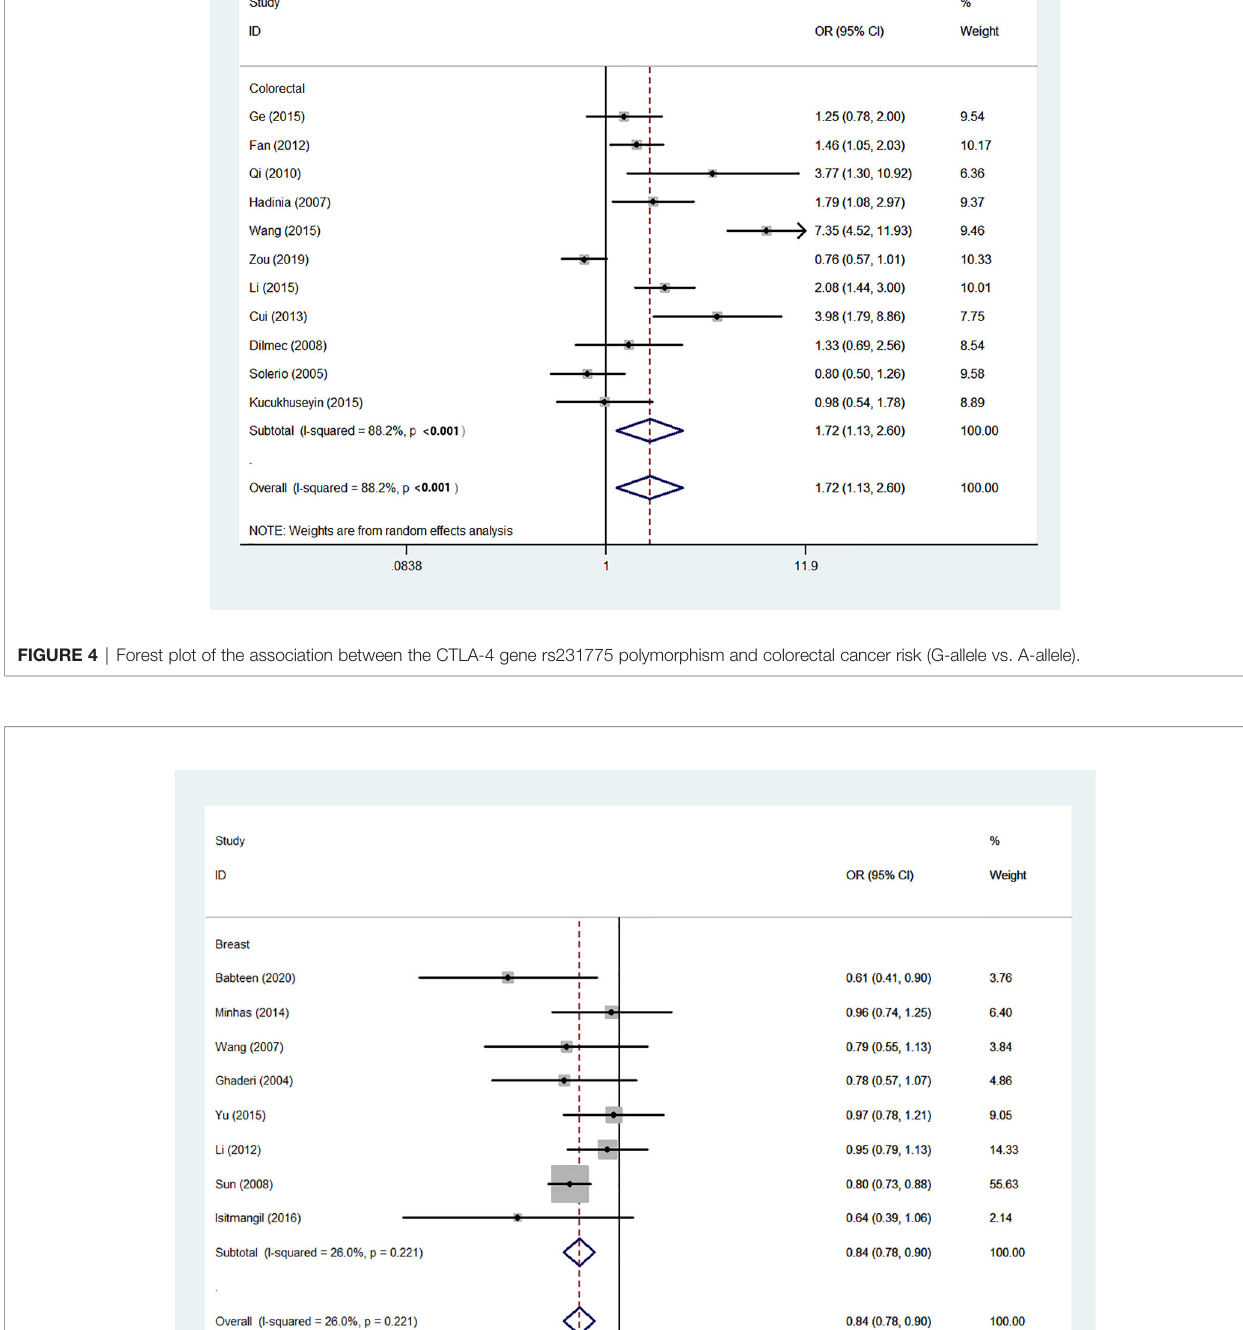
Frontiers in Oncology |